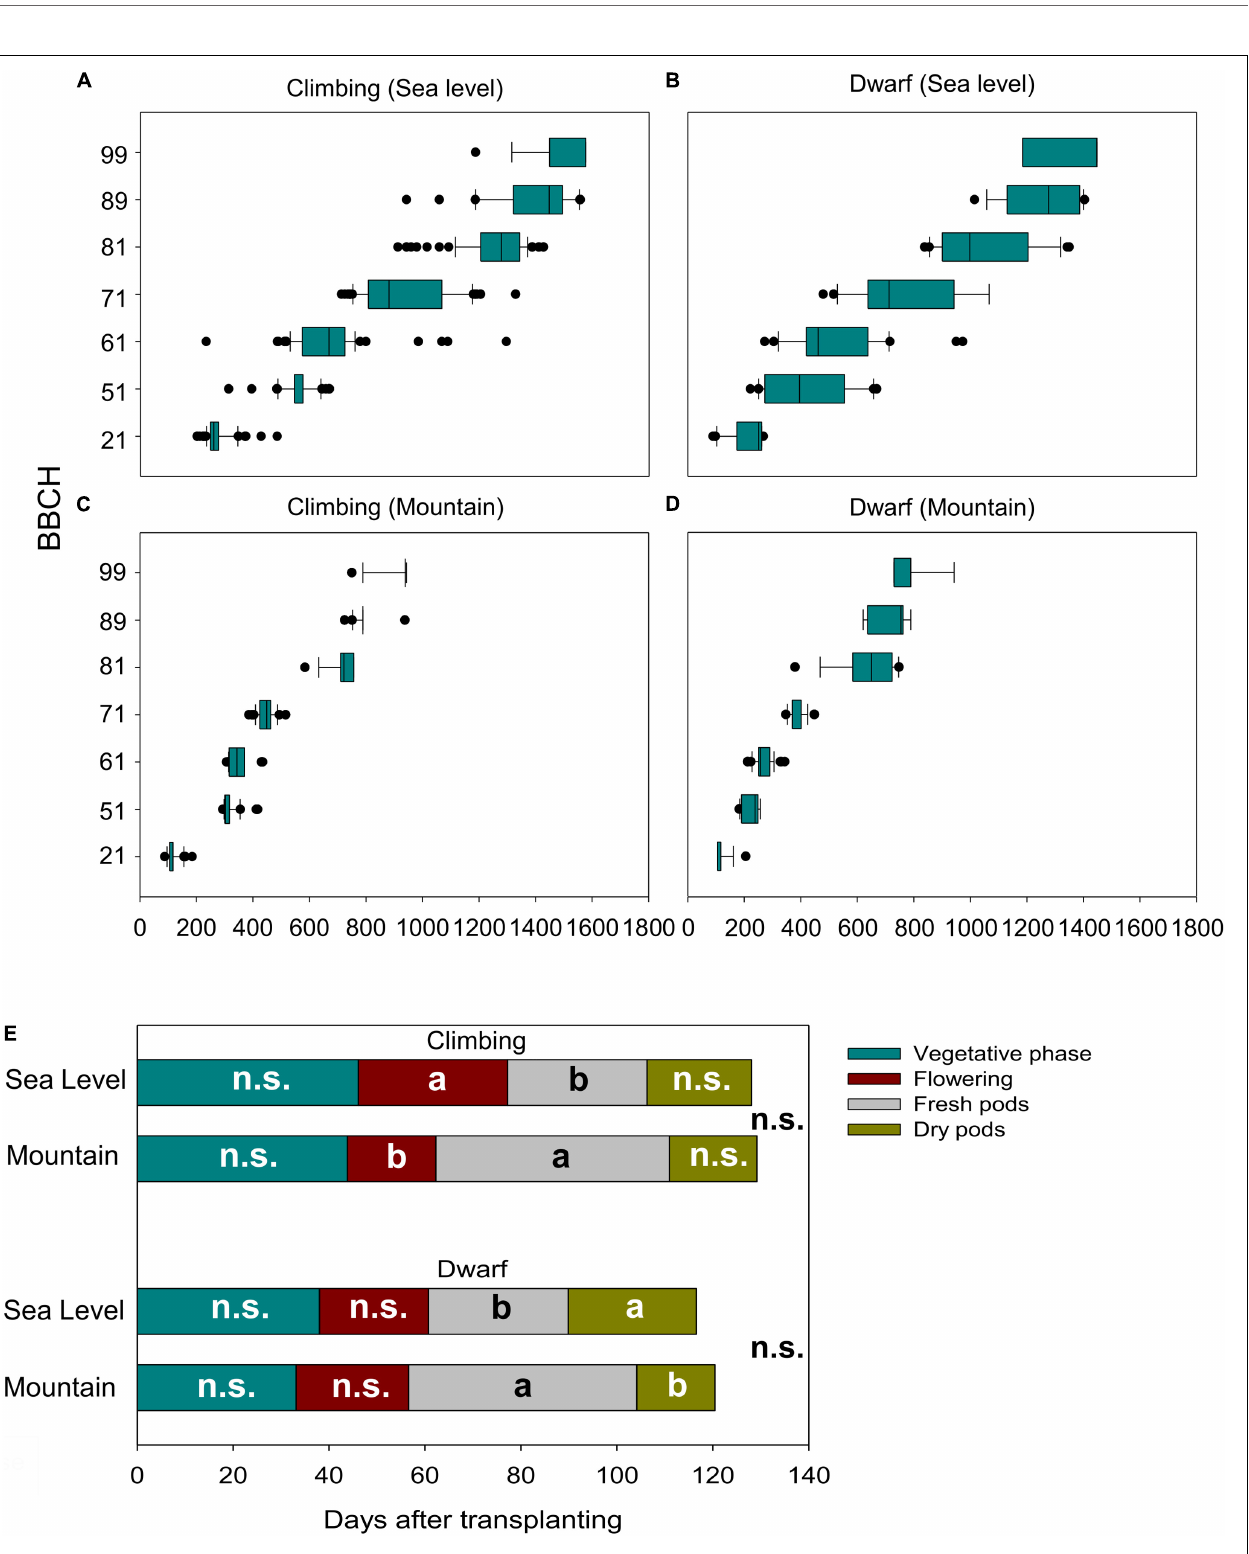
FIGURE 3 | Relationship of the plant development (BBCH-scale) and the cumulative growing degree days (GDD) for climbing accessions at sea level (A) in the mountains (C) and dwarf accessions at the sea level (B) and in the mountains (D) and the effect of the environments on the length of development stages of climbing and dwarf accessions (E) . Different letters in the same stage indicate a significant difference ( α = 0.05); n.s., not significant differences.